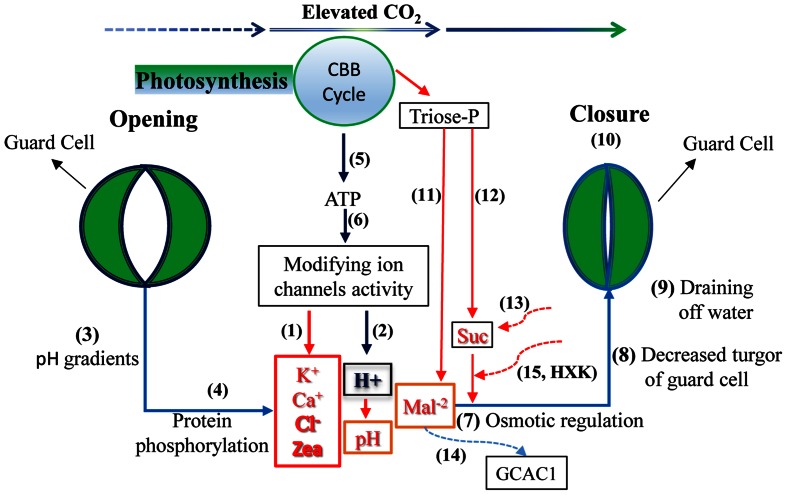
Possible stomatal response mechanisms controlling guard cells (GC) under elevated CO2. With rising CO2, a depolarization in GCs appears: the levels of K+, Ca2+, Cl-, and zeaxanthin (Zea) may decrease (1), whereas the H+ concentration may remain at a high level (2) leading to a lower pH value. The pH gradient (3), protein phosphorylation (4), and photosynthesis-derived ATP (5, 6) are involved in the regulation process by modifying channel activities; together, they promote osmotic regulation (7) and decrease GC turgor (8) consequently causing the GCs to drain water (9) leading to stomatal closure to some extent (10). Meanwhile, Calvin–Benson–Basshan (CBB) cycle and sugar metabolism in GC may produce less malate (Mal2-), (11) and sucrose (Suc) (12) with triose phosphate (triose-P) at eCO2, which also affects osmotic regulation. Furthermore, elevated CO2 may reduce Suc accumulation in the vicinity of the GC wall from the mesophyll due to the limitation of some apoplastic Suc in the transpiration stream toward GC (13) and enhance Mal2- transport from GCs into mesophyll cells by stimulating anion efflux through channels such as GCAG1 and the potential involvement of the AtABCB14 gene (14), also resulting in stomatal closure. Finally, hexokinase (HXK) involvement may limit sugar synthesis and its entrance into GCs from mesophyll cells (15) and then inducing stomatal closure (e.g., Webb et al., 1996; Assmann, 1999; Schroeder et al., 2001; Kang et al., 2007; Lee et al., 2008; Kim et al., 2010; Fujita et al., 2013; Kelly et al., 2013; Lawson et al., 2014; Negi et al., 2014).